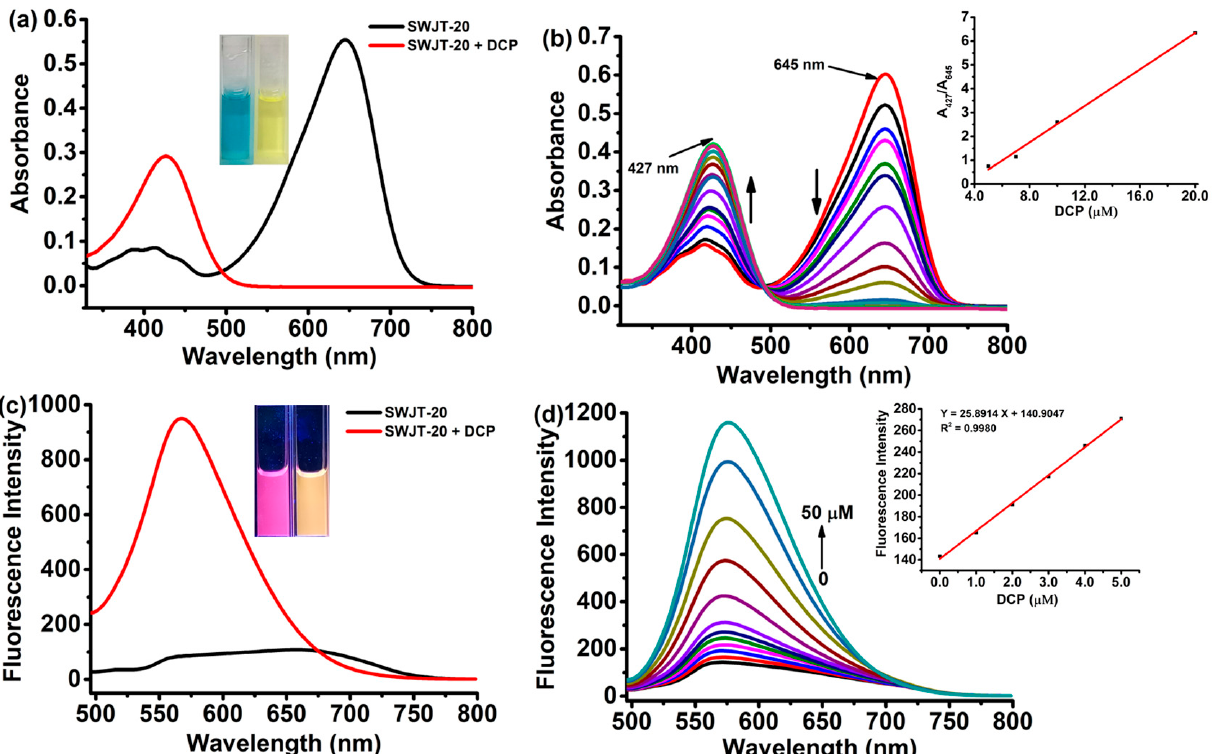
Figure 1. ( a ) The absorption spectra of SWJT-20 (10.0 µ M) and SWJT-20 + DCP (50.0 µ M) in DMF. Inset: Color changes under visible light before and after the addition of DCP to SWJT-20 . ( b ) The absorption spectra of SWJT-20 (10.0 µ M) and gradual addition of DCP (0–50.0 µ M) in DMF. Inset: Ratios of absorbance at 427 and 645 nm as a function of DCP concentration (5.0–20.0 µ M). ( c ) The fluorescent spectra of SWJT-20 (10.0 µ M, λ ex = 427 nm) and SWJT-20 + DCP (50.0 µ M) in DMF. Inset: Color changes under UV light at 365 nm before and after the addition of DCP to SWJT-20 . ( d ) Fluorescence titrations of SWJT-20 (10.0 µ M, λ ex = 427 nm) and different concentrations of DCP (0–50.0 µ M) in DMF. Inset: Linear relationship between fluorescence intensity at 574 nm and the concentration of DCP (0–5.0 µ M).